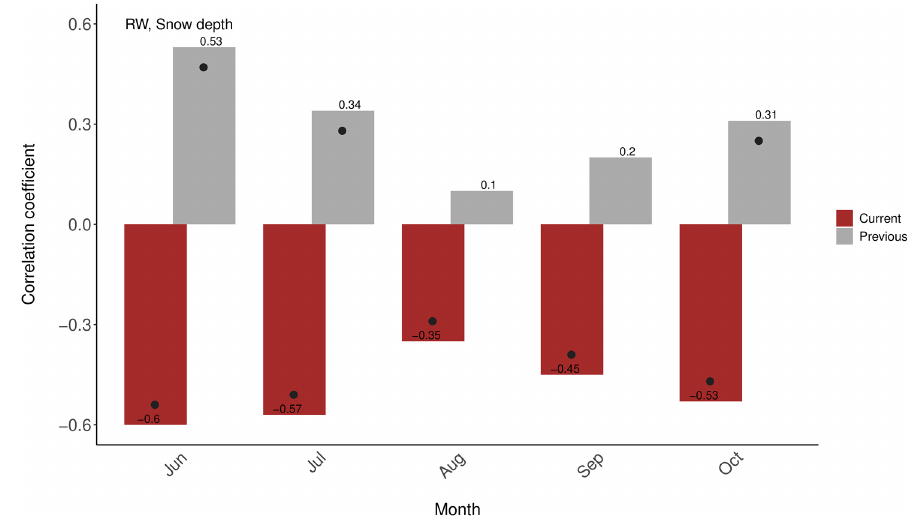
Figure 10. Correlations between P. lawrencei RW chronology and mean monthly snow depth at Spencers Creek, for the period 1954–1998. Black dots indicate statistical